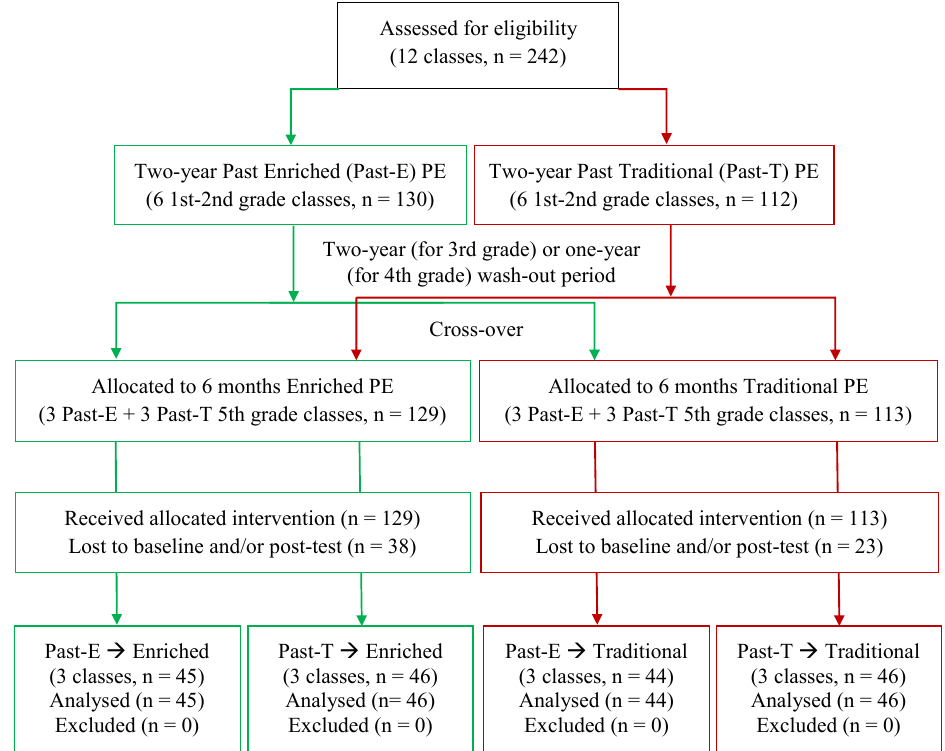
Figure 1. Study flow diagram for the class-randomized cross-over trial.